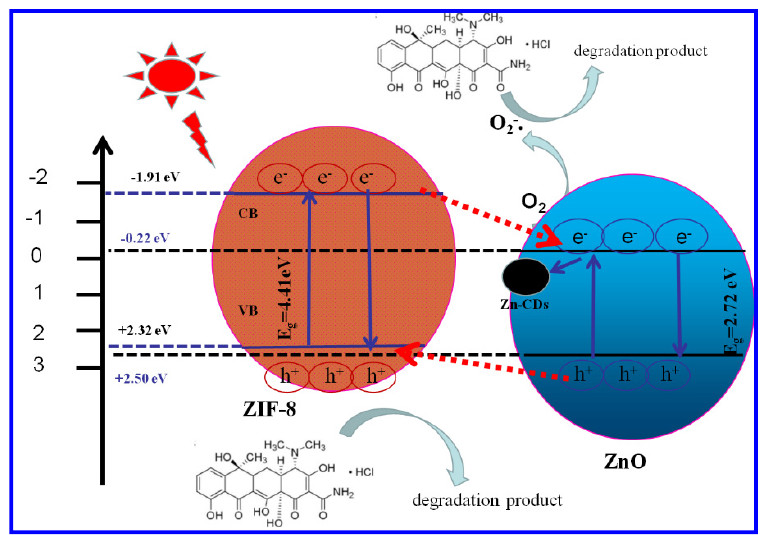
Figure 10. Proposed mechanism of photocatalytic degradation for TC.